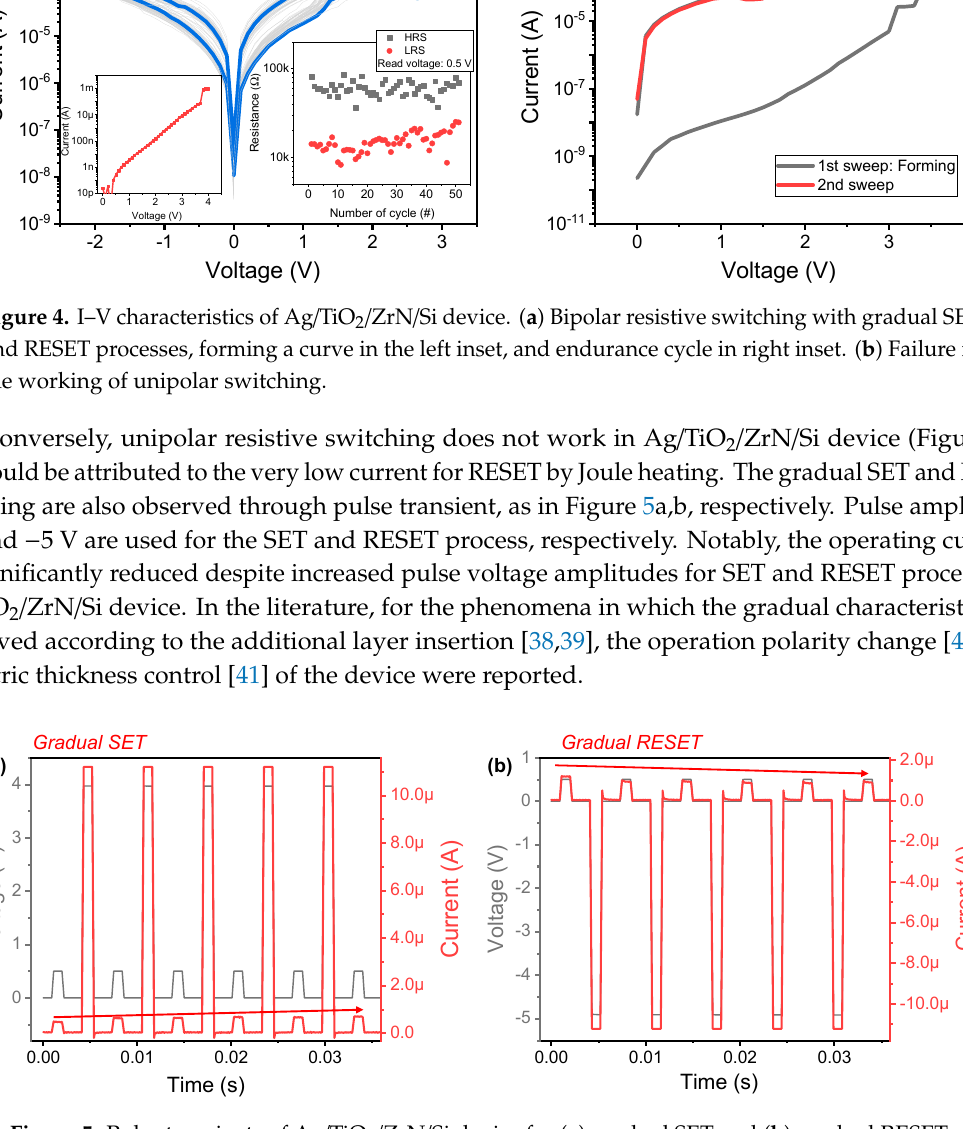
Figure 5. Pulse transients of Ag/TiO 2 /ZrN/Si device for ( a ) gradual SET and ( b ) gradual RESET.